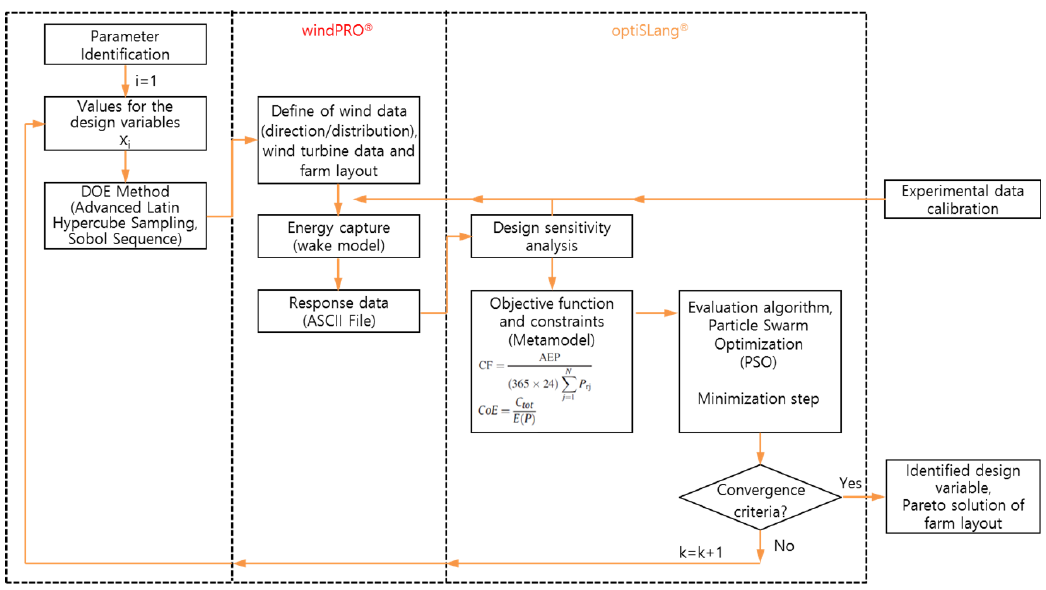
Figure 2. Framework for wind farm layout optimization.